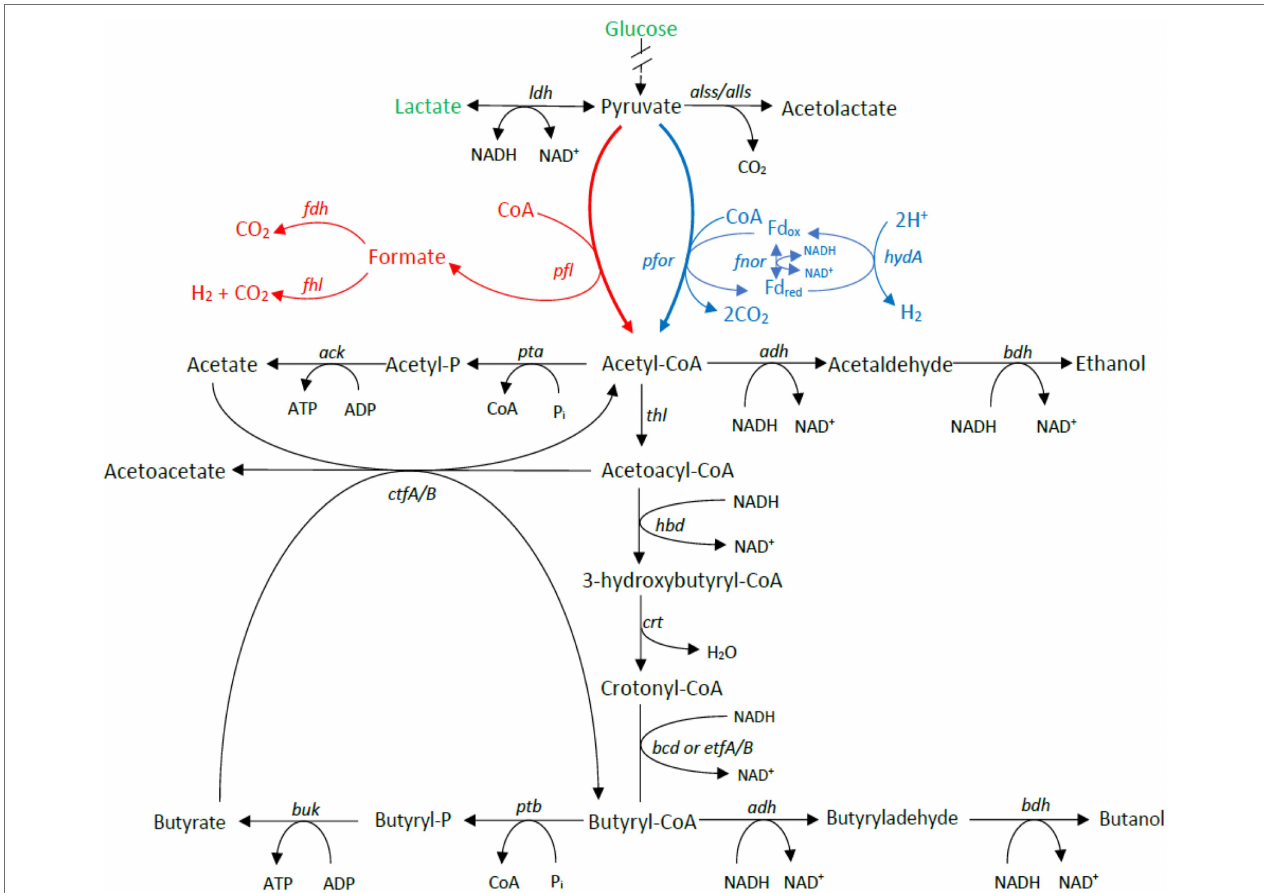
FIGURE 6 | Genome-based reconstruction of C. estertheticum and C. tagluense central fermentation pathway. Two key pathways involved in gas production are highlighted in red or blue colors. The main substrates utilized by both species in meat, glucose, and lactate are highlighted in green. ldh , L-lactate dehydrogenase; alls and alss , acetolactate synthase large and small subunits; pfor , NADP + pyruvate ferrodoxin oxidoreductase ( fnor-nfn ); pta , phosphate acetyltransferase; ack , acetate kinase; adh , alcohol dehydrogenase; thl , thiolase; hbd , hydroxybutyryl-coA dehydrogenase; crt , crotonase; bcd/etfAB , butyryl-CoA dehydrogenase/electron transfer flavoprotein NAD + ferredoxin, subunits alpha and beta; ptb , phosphotransbutyrylase; buk , butyrate kinase; ctfA/B , coA-transferase subunits A/B; bdh , butanol dehydrogenase; pfl , pyruvate formate lyase; and hydA , hydrogenase